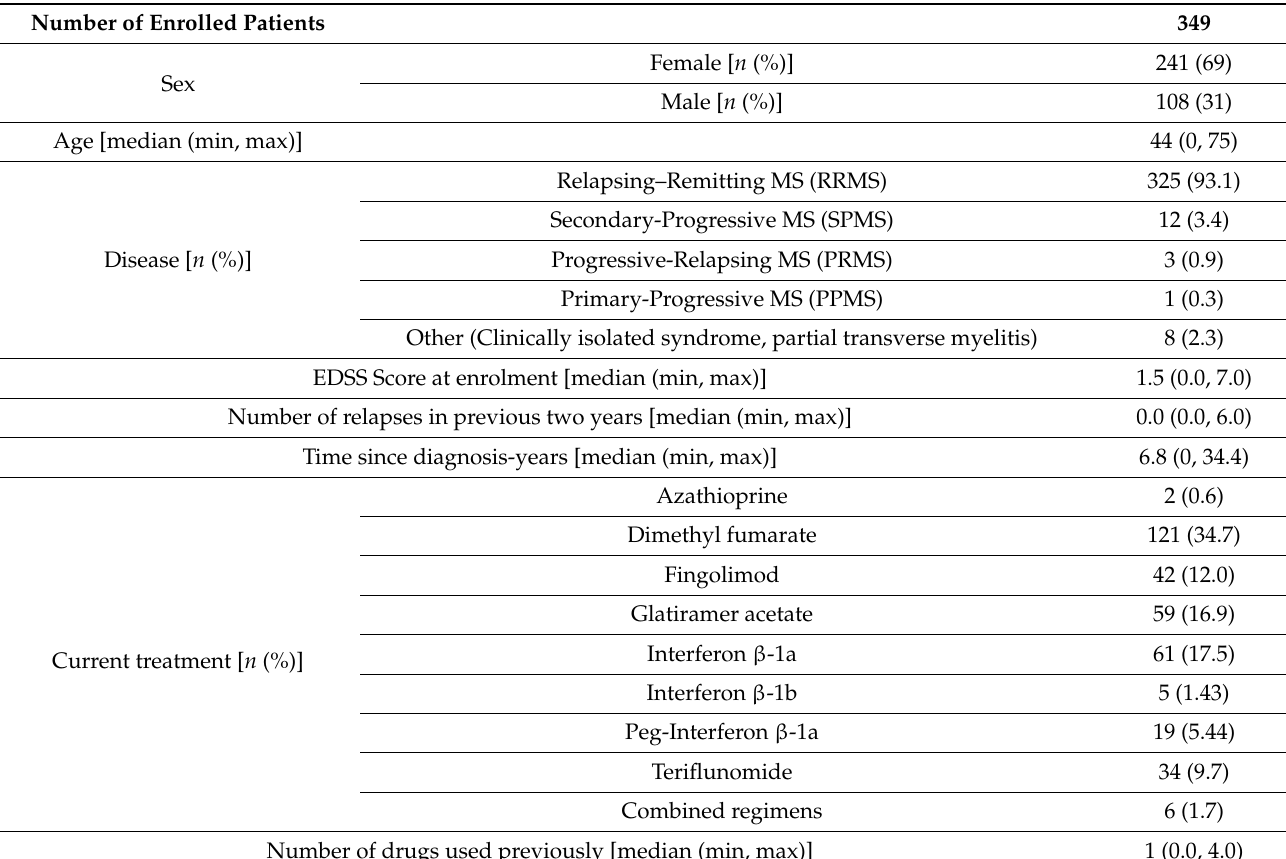
Table 1. Clinical characteristics of